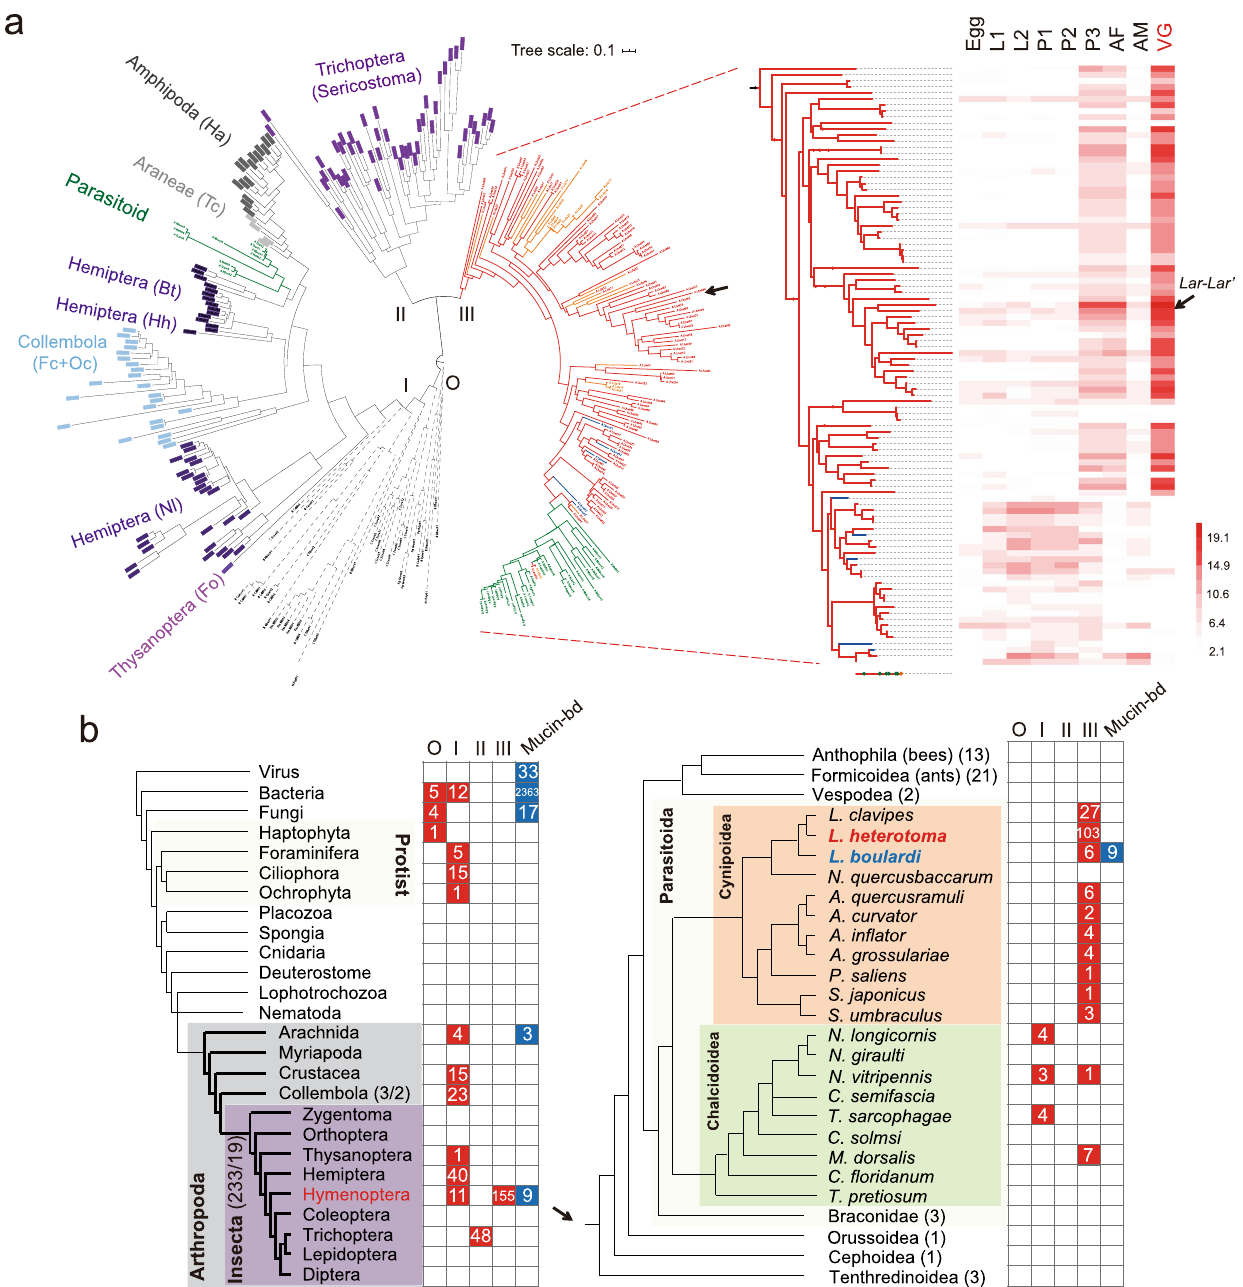
Fig. 3 Genomic origin and evolution of Lar . a Phylogenetic tree of all identi fi ed Lar homologs. Genes from Lh, Lb, Lc, and other parasitoid species are shown by red, blue, orange, and green branches, respectively. Nodes with colored backgrounds indicate genes from other animal species, while those in gray indicate microorganism genes. Fo Frankliniella occidentalis , Nl Nilaparvata lugens , Fc Folsomia candida , Oc Orchesella cincta , Hh Halyomorpha halys , Bt Bemisia tabaci , Tc Trichonephila clavipes , Ha Hyalella azteca . A local phylogeny containing the Lh and Lb genes is independently shown with an